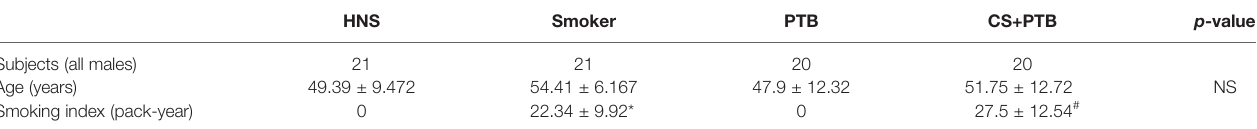
TABLE 1 | Demographic characteristics of study population.